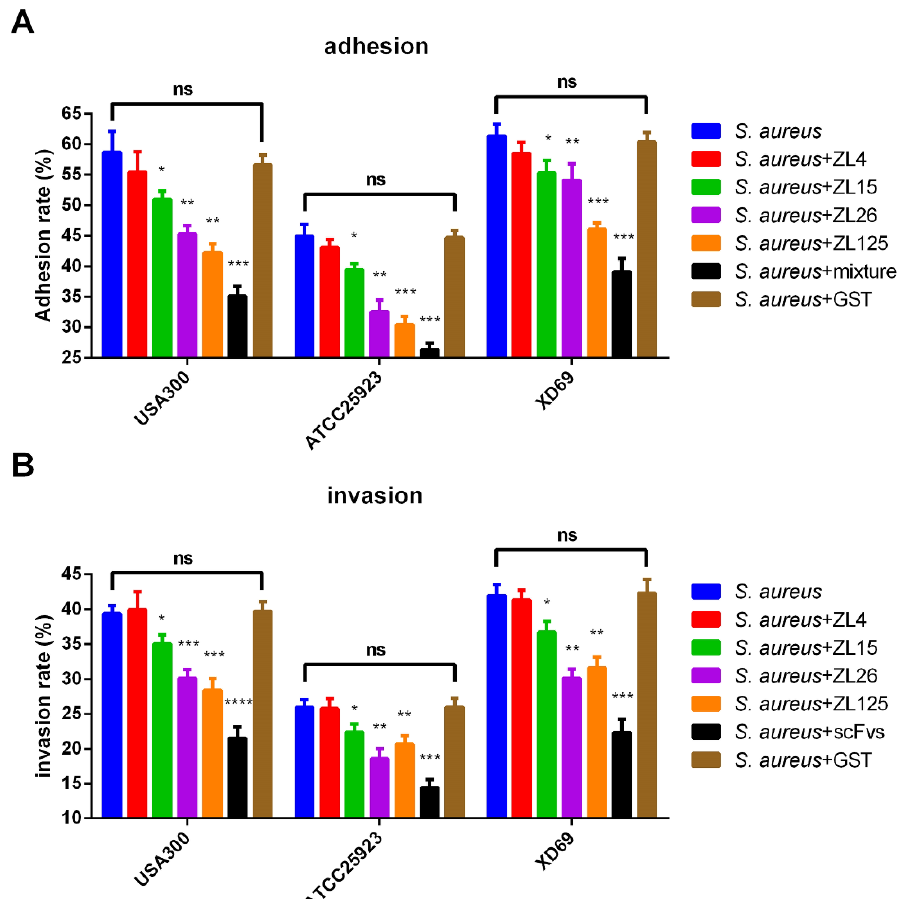
Figure 3. Adhesion ( A ) and invasion ( B ) rate of three S. aureus on MAC-T cells or incubated